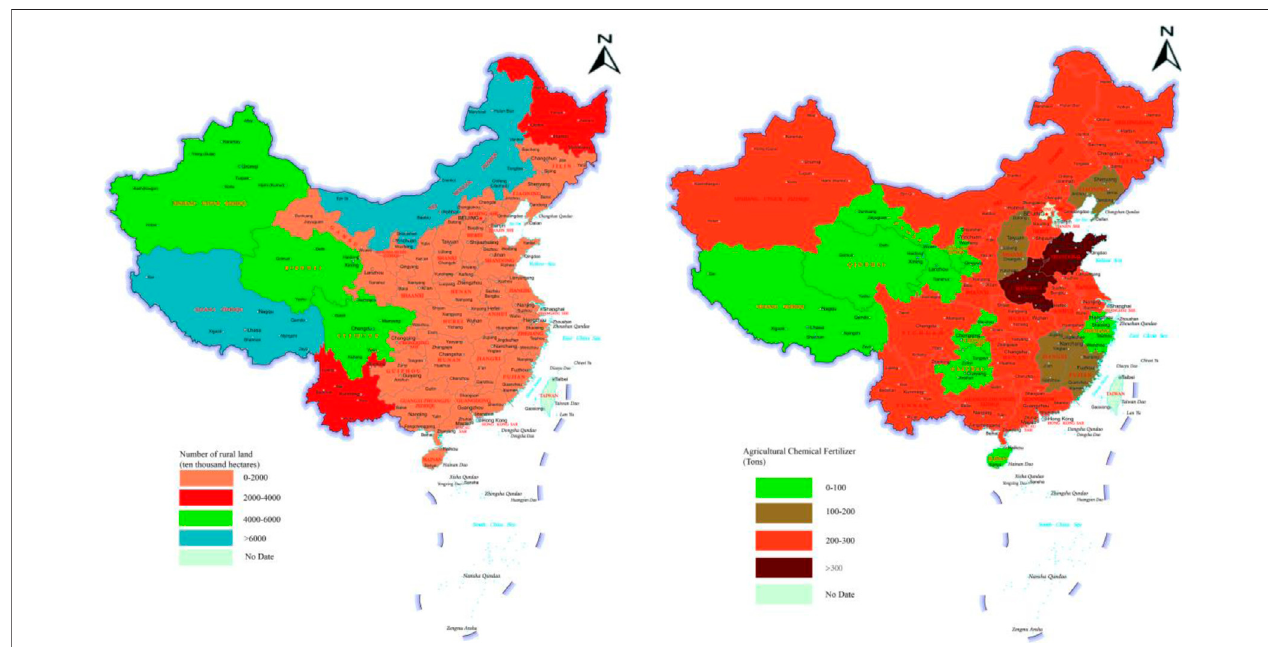
FIGURE2| Theareaofagriculturallandandthepurevolumeofagriculturalchemicalfertilizersin2019.[ (A) Agriculturallandarea; (B) Agriculturalchemicalfertilizer].